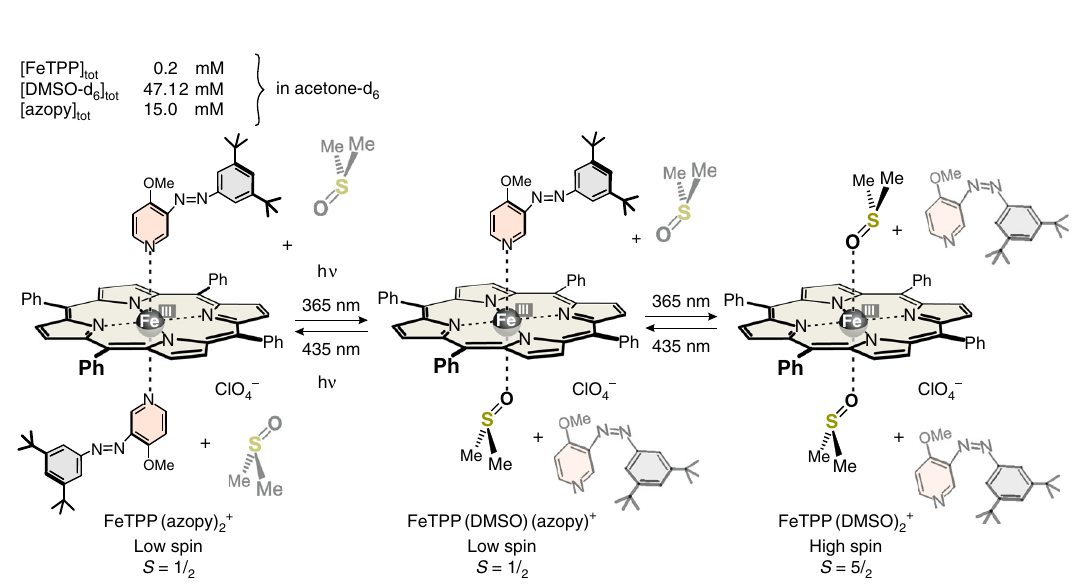
Fig. 5 Light-induced spin switching of iron(III) porphyrin (FeTPP + ) using azopy as a PDL. The composition of the solution is calculated from the binding constants K 1 ′ , K 2 ′ and K 1 , K 2 , and is listed for the photostationary states (PSS) at 435 and 365 nm in Table 1. The calculations are based on the assumption that cis azopyridine does not coordinate to FeTPP + , and that FeTPP(DMSO)(azopy) + is a low-spin complex